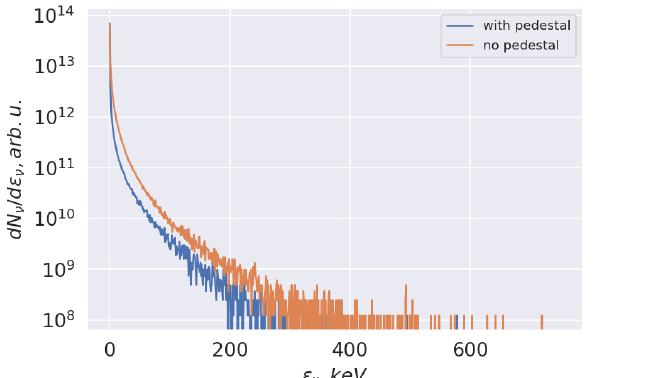
Figure 9. Comparison of photon spectra obtained from the simulations for 11 fs laser pulses with and without 50 fs pedestal. The pedestal amplitude was a 0 = 1.1. The main pulse amplitude was a 0 = 2.5 in the case with the pedestal and a 0 = 7.5 in the case without the